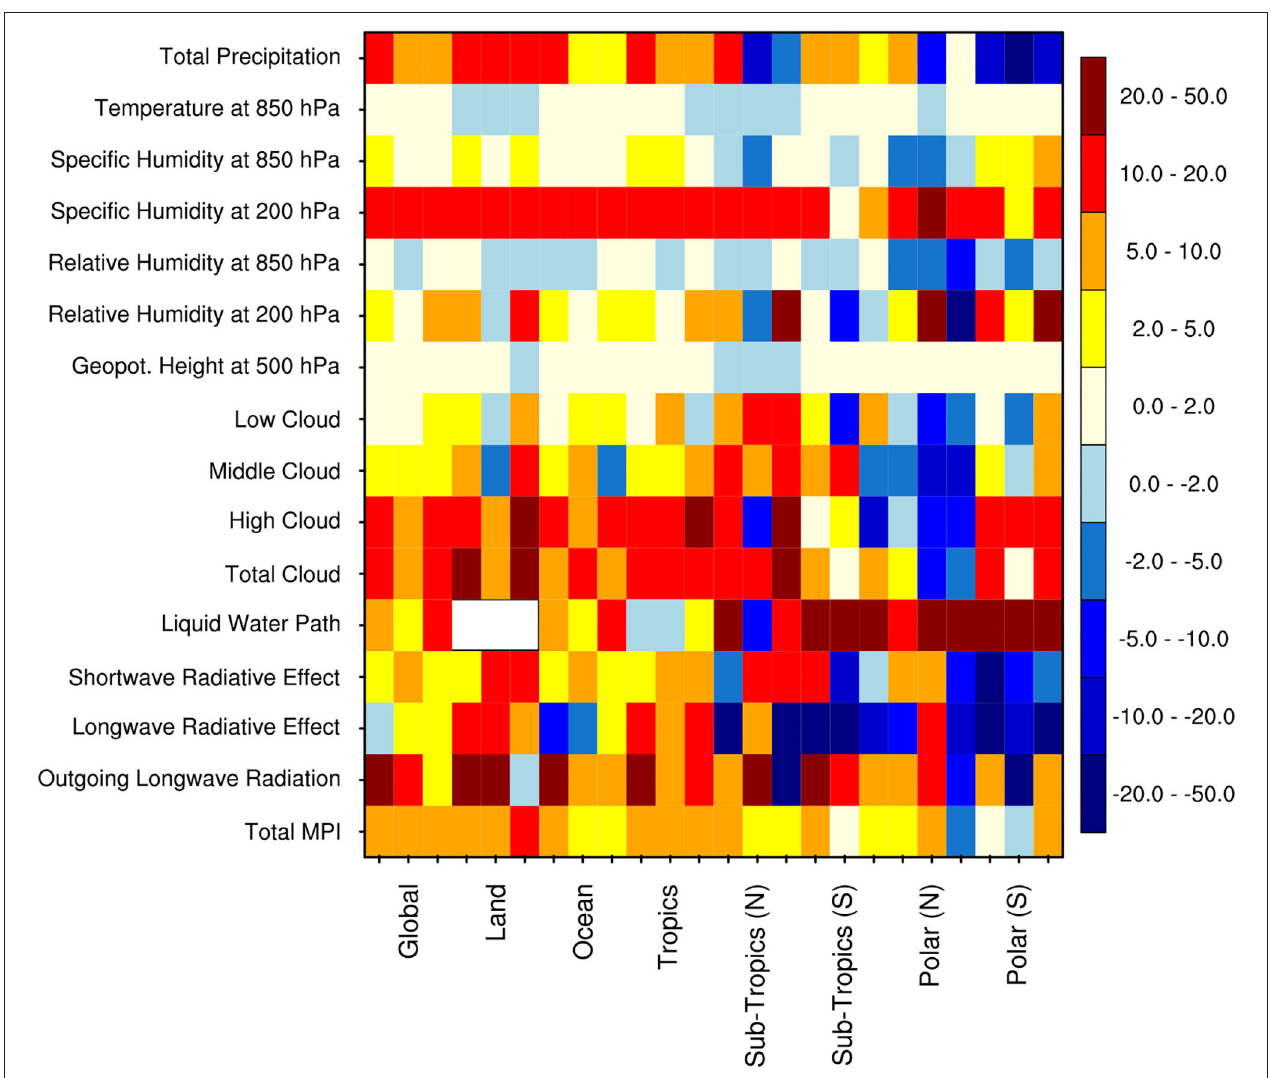
FIGURE 14 | The Model Performance Index (MPI in percent) resulting from simulations of various climate variables over the global, tropics (30 ◦ N − 30 ◦ S), norther subtropics (30–60 ◦ N), southern sub-tropics (30–60 ◦ S), northern polar (60–90 ◦ N), and southern polar (60–90 ◦ S) regions, across different periods [i.e., Annual (ANN), June-August (JJA), December-February (DJF)]. The MPI is constructed using a metric developed by Zhang (2015). The contours in color show the percentage improvement (positive values) or deterioration (negative values) for different climate variables from the simulation with posterior mean parameters with respect to the default model simulation. Total MPI—model performance as averaged over all climate variables. Following observations and reanalysis data are used for construction of this metrics, the Global Precipitation Climatology Project (Adler et al., 2003) for total precipitation, the Clouds and Earth’s Radiant Energy System-Energy